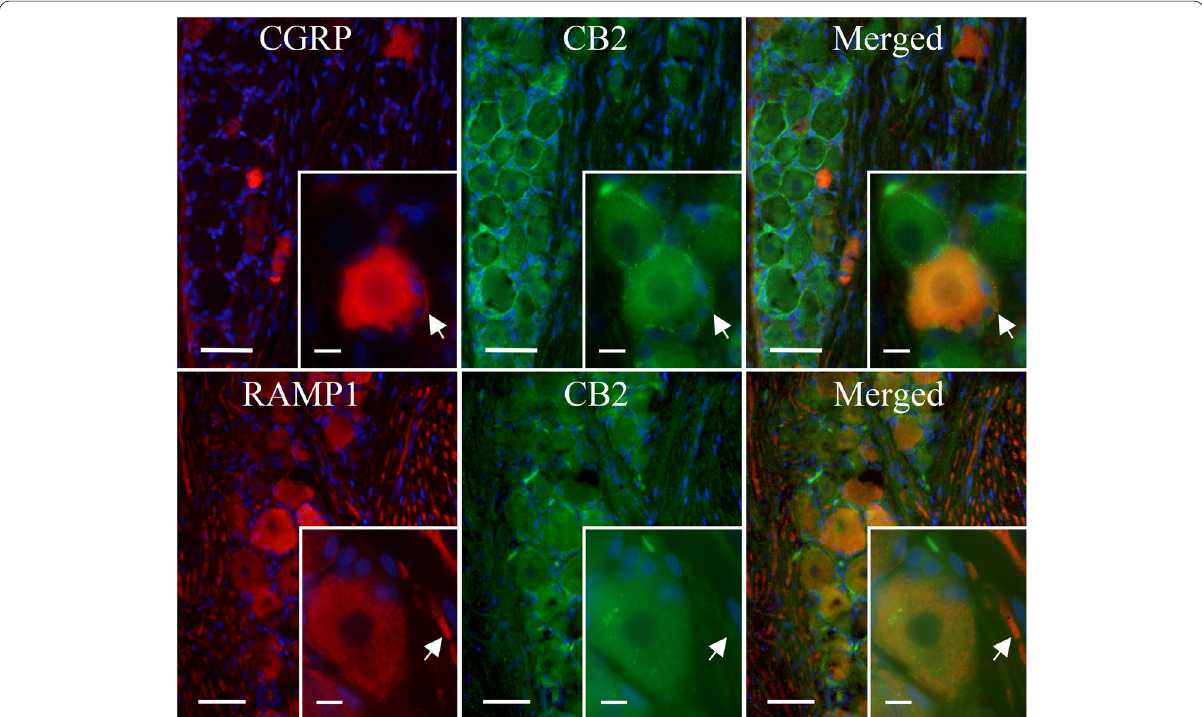
Fig. 5 The expression of CB2, CGRP and RAMP1 in the TG. IHC localization of CB2, CGRP and the functional CGRP receptor (by staining for RAMP1) in the TG. Blue represents cell nuclei; orange represents colocalization of CGRP (upper panel) or RAMP1 (lower panel) with CB2; globular regions represent neuronal somas and fibrous regions represent individual neuronal fibres. Large image scale corresponds to 50 mm, and the insert scale corresponds to 10 μm. The arrows mark unmyelinated C-fibres (upper panel) and myelinated Aδ-fibres (lower panel)